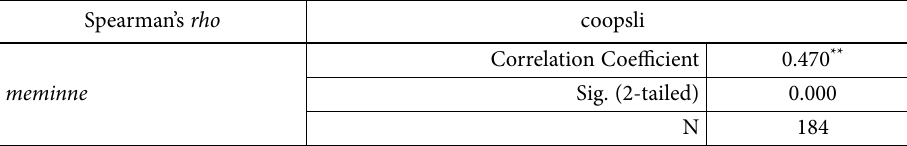
Correlation Coefficient 0.470 ** Sig. (2-tailed) 0.000 N 184